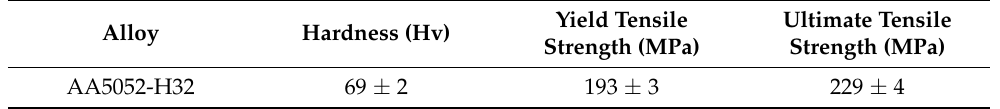
Table 1. Chemistry composition of the AA5052-H32 alloy material.